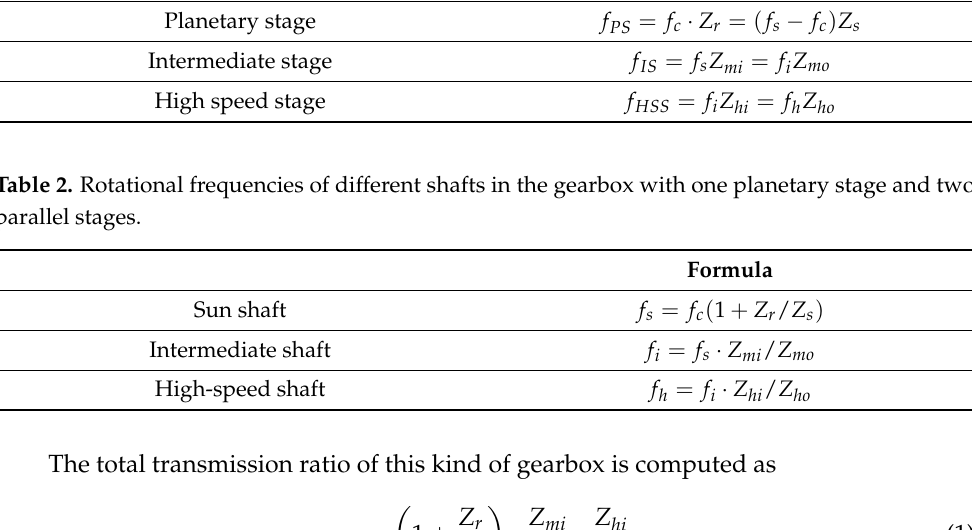
Figure 3. Structure of wind turbine gearbox with one planetary stage and two parallel stages: 1—planet carrier of planetary stage; 2—sun shaft; 3—intermediate shaft; 4—high-speed shaft. The mesh frequencies of different stages and the rotational frequencies of different shafts are computed as in Tables 1 and 2. Table 1. Mesh frequencies of different stages in the gearbox with one planetary stage and two parallel stages.